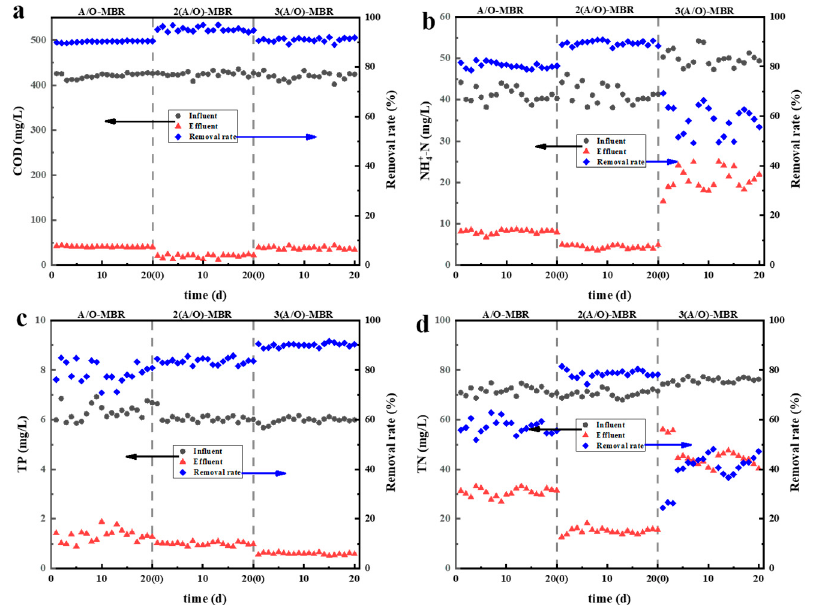
Figure 2. Treatment effect of overflow O-MAO-MBR on sewage ( a ) COD change, ( b ) NH + changes, ( c ) TP changes, and ( d ) TN changes.